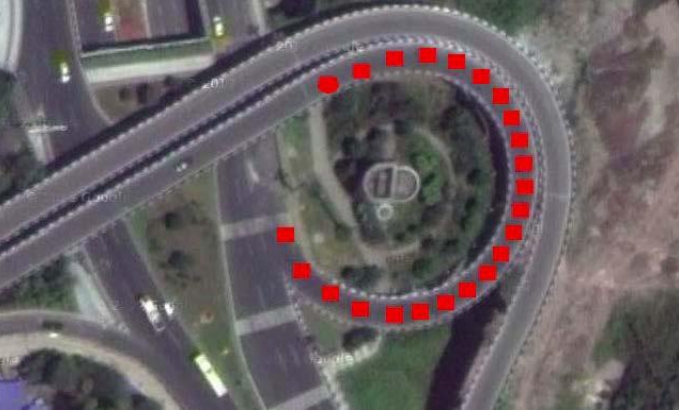
Figure 8. Turntable road and locations of 23 GPS epochs for data section F.